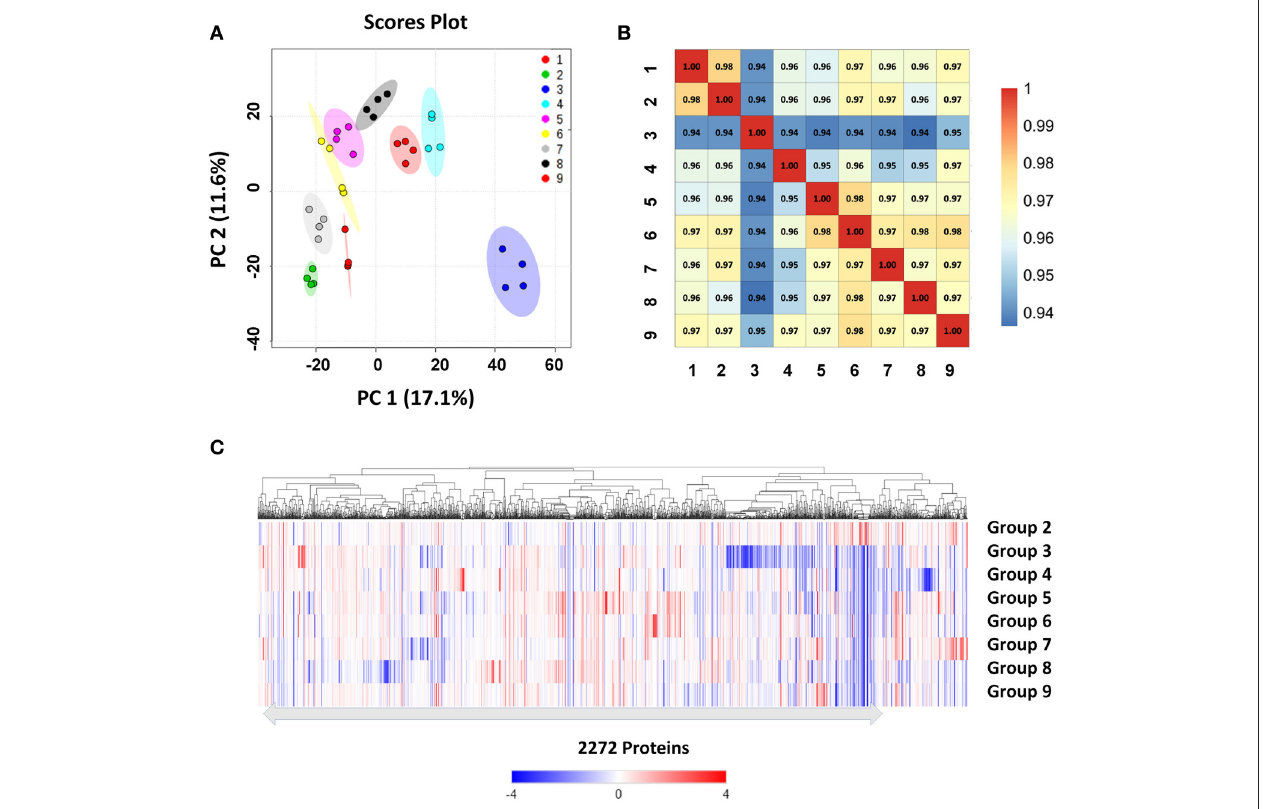
FIGURE 3 | Clustering and correlation of quantified proteins of B. abortus under environmental stress. (A) PCoA comparing the level of variance among the biological and technical replicates in the nine growth conditions for all the 2,272 proteins obtained after one-way ANOVA. Each dot represents an independent biological replicate. (B) Pearson’s correlation coefficients of the protein intensities in all nine groups compared against each other. (C) Heatmap and hierarchical clustering of quantified proteins from cells under stress treatments. Hierarchical clustering was performed based on all quantified proteins. Relative protein expression under stress conditions was compared to the control